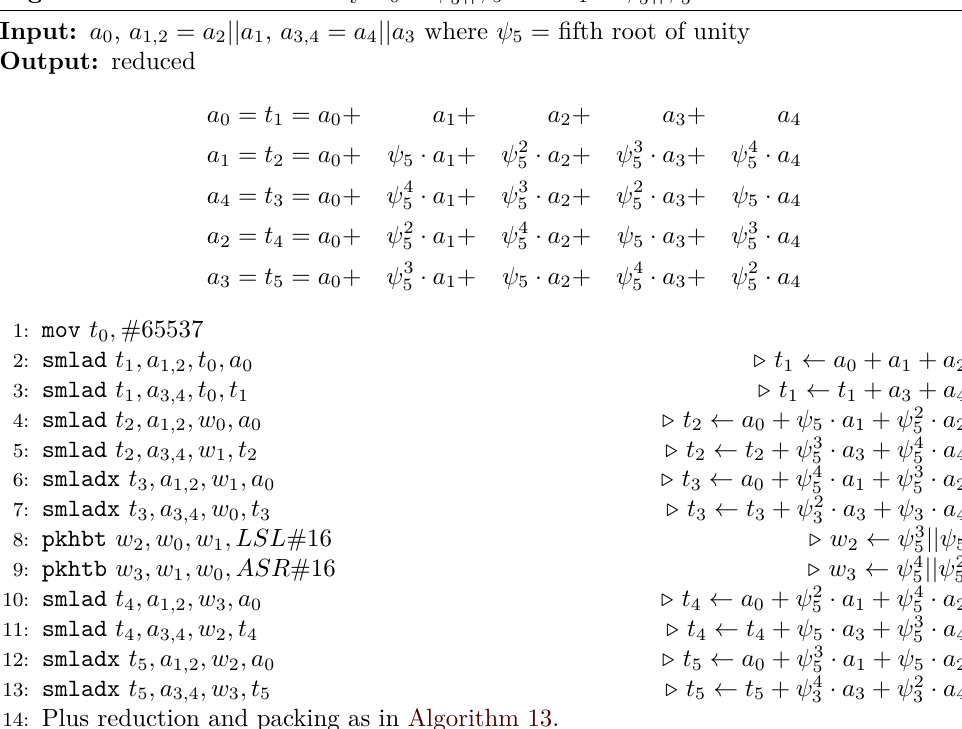
Algorithm 14 Radix-5 butterfly w 0 = ψ 2